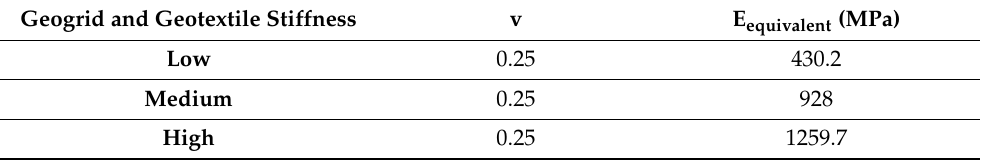
Table 4. Geosynthetics equivalent elastic modulus for different stiffnesses.